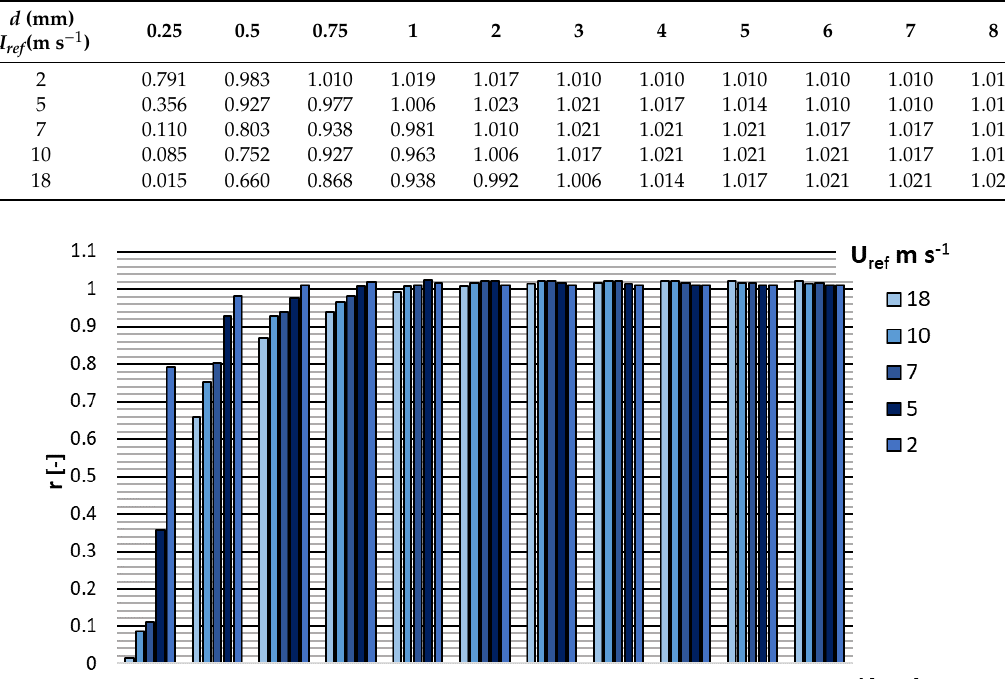
Figure 2. Catch ratios per each drop size, resulting from the LPT model run at different wind speed and based on the airflow fields simulated for the Casella cylindrical rain gauge.